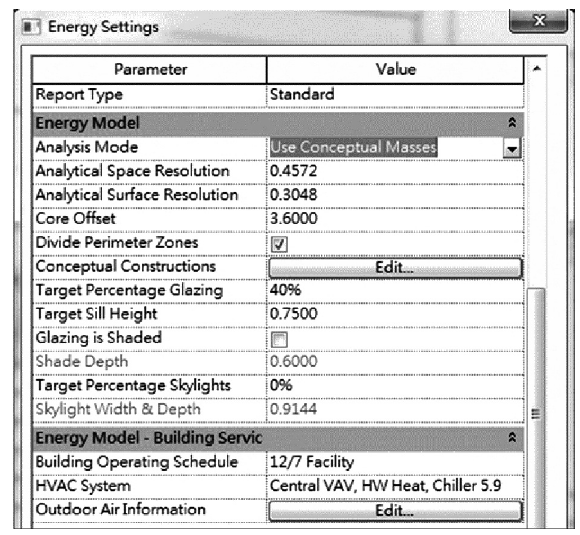
Table 4. Internal building settings: attributes and